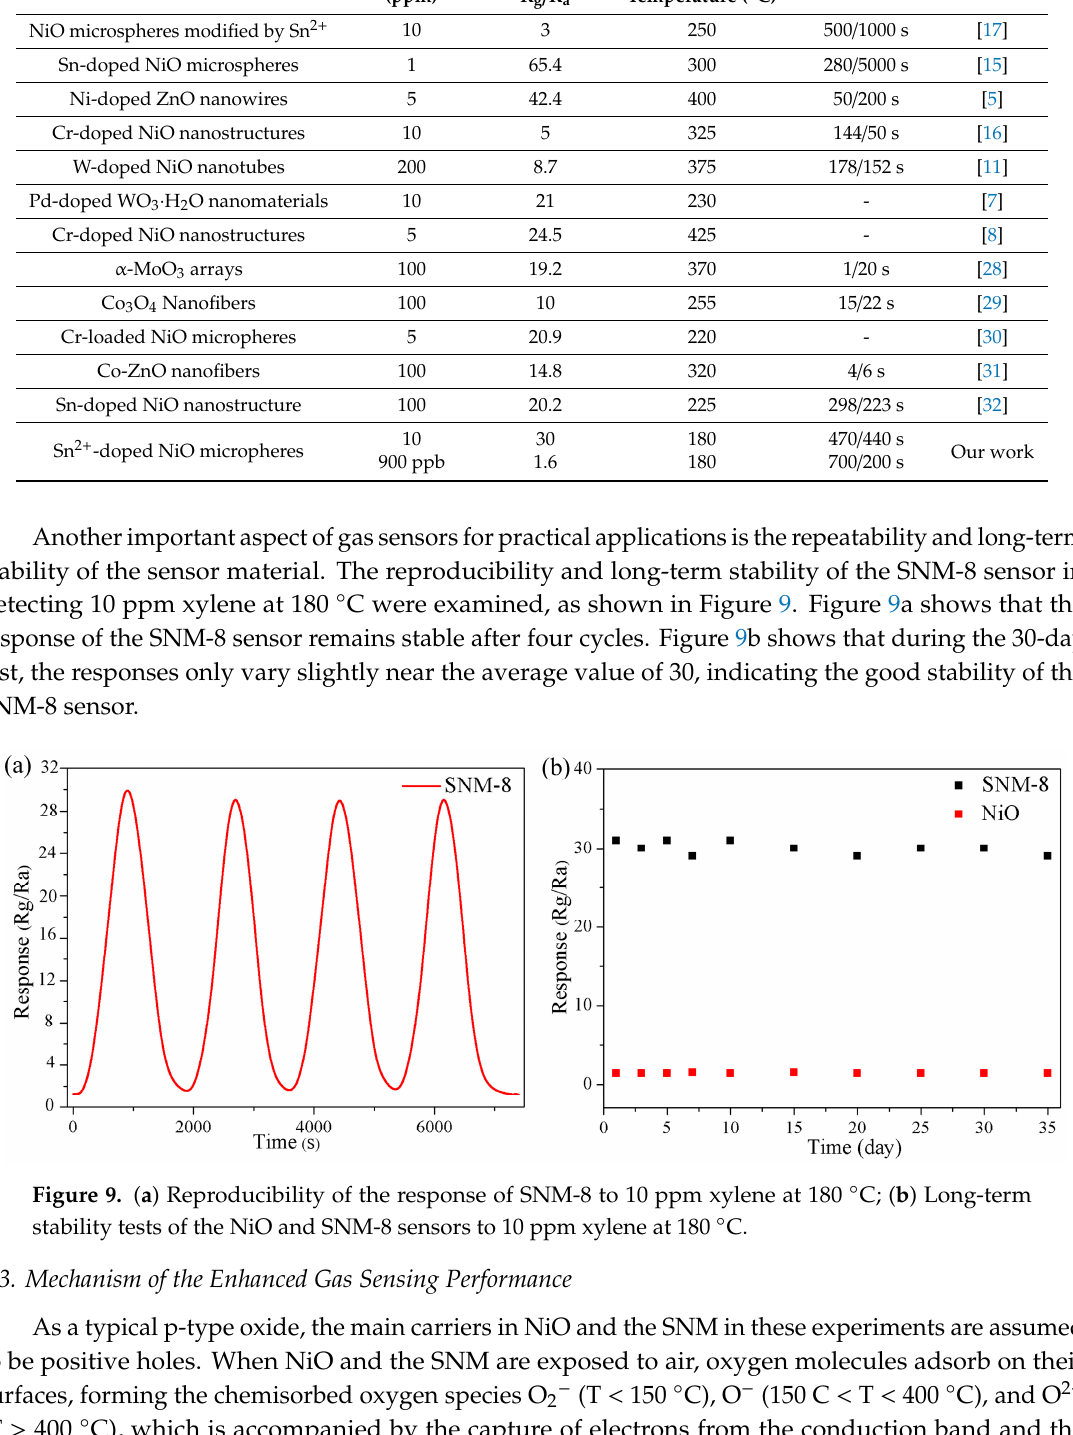
Table 1. Gas sensing performance between this work and previous works in literatures.